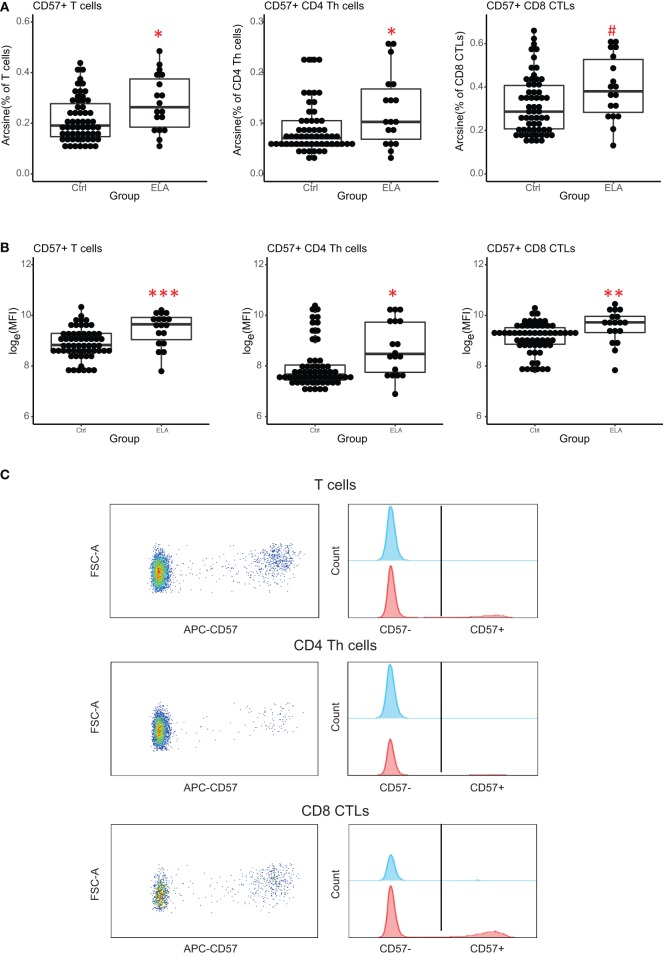
Senescence marker CD57 on T cells. ELA participants have more CD57+ T cells (total and subsets Th and CTLs) (A) and the expression of CD57 per cell is higher (MFI) (B). Y axis shows percentages of parent populations after an arcsine transformation, or log-transformed MFI values. Representative dot plots and histograms of CD57 expression on T cells and its subsets (C). Statistics: linear model with group and experimental day as independent variables, and arcsine-transformed percentages or log-transformed MFI of CD57+ cells as dependent variable. p-Values are corrected for multiplicity with false discovery rate. #p < 0.10, *p < 0.05, **p < 0.01, ***p < 0.001. Abbreviations: Ctrl, control; ELA, early life adversity; MFI, median fluorescent intensity; CTL, cytotoxic T lymphocyte; Th cell, T helper cell.